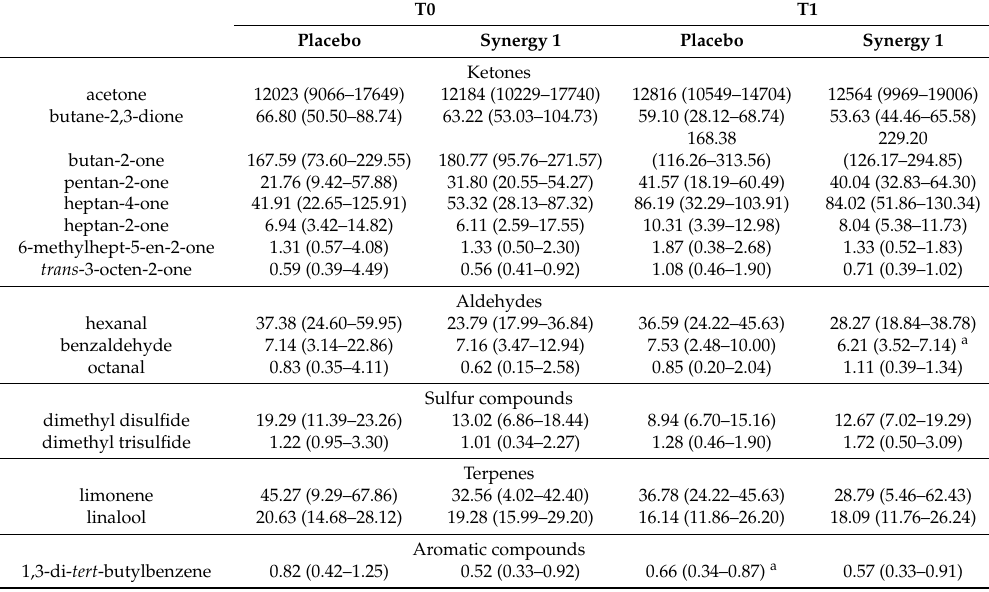
Table 1. Volatile organic compounds (VOCs) (nmol/L) detected and quantified in the urine of children from Synergy 1 and placebo group, before (T0) and after (T1) the intervention, expressed as median